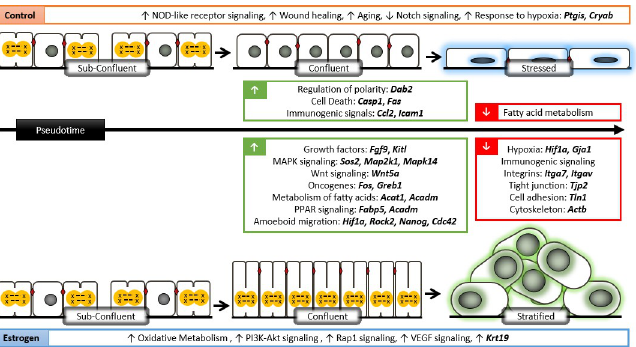
Fig 8. Molecular signaling mechanisms of estrogen-induced dysplasia in OSE. Sub-confluent cells from control and E2 cultures are phenotypically similar where they are proliferative and metabolically active. With increasing confluence, cell-cell adhesions form between control cells and proliferation is slowed due to contact inhibition mediated by regulators of polarity. Without E2, control cells become stressed with increasing confluence and upregulate genes associated with hypoxia, cell death, and inflammatory responses involving immune cell recruitment through the TNF signalling pathway. E2 treated cells suppress inflammatory immunogenic signals, overcome hypoxia via up-regulation of Hif1a , show up-regulation of growth factors, mediators of MAPK/Wnt/PI3K-Akt signaling, known oncogenes, and metabolism. With persistent proliferation, columnar cells are first observed to maximally accommodate proliferative cells in an already confluent monolayer. While Krt19 is consistently higher in E2 treated OSE cells, these cells show loss of epithelial architecture and upregulate key genes involved in amoeboid migration to detach from the ECM and move through dense hypoxic